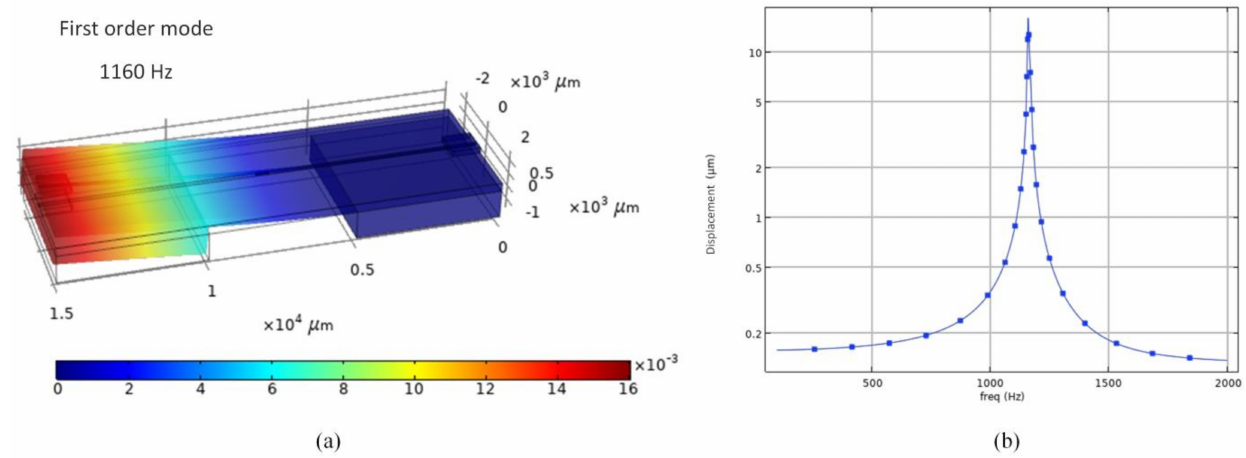
Figure 2. The finite element simulation results of FOFPA. ( a ) the first order mode of FOFPA. ( b ) frequency domain analysis of